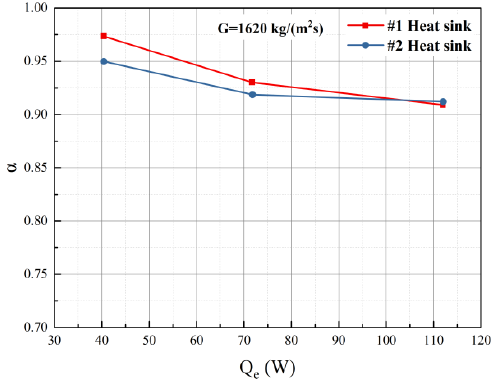
Figure 4. Heat transfer efficiency.